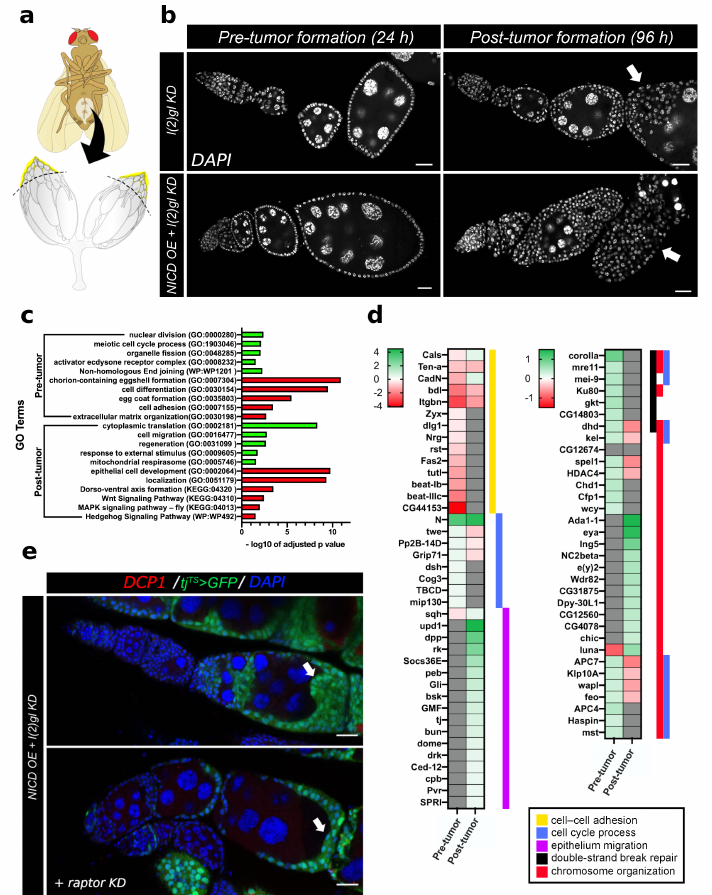
Figure 5. RNA sequencing reveals the Notch-induced genes regulating tumorigenesis and cell survival. ( a ) An illustration of sample collection method. Anterior ovaries, including egg chamber stages up to but not including stage 10A (highlighted in yellow) were collected for library preparation and sequencing. ( b ) Representative confocal images of tumor samples collected at either 24 h (after Gal4 induction but before tumor formation) and 96 h (after significant tumor formation). White (DAPI) marks nuclei. Arrows point to tumor overgrowth in both genetic backgrounds at 96 h. Scale bar = 20 µ m. ( c ) Results from GO term enrichment analysis of pre- and post-tumor genes which were up or down regulated in NICD OE + l(2)gl KD samples compared to l(2)gl KD. Significantly enriched GO terms for upregulated (green) and downregulated (red) genes are shown plotted with respective negative log 10 of adjusted p values. ( d ) Heatmap highlighting expression patterns (LogFC) of select genes from pre- to post-tumor conditions. Colored bars to the right of each heatmap signify the GO term each gene belongs to: cell–cell adhesion (GO:0098609), cell cycle process (GO:0022402), epithelium migration (GO:0090132), double-strand break repair (GO:0006302), or chromosome organization (GO:0051276). ( e ) One gene identified, raptor , is upregulated in NICD OE tumor cells prior to tumor formation (0.57 LogFC) but downregulated following tumor formation ( − 0.51 LogFC). Consistent with a role in Notch-induced tumor formation, raptor knock-down (KD) in an NICD OE + l(2)gl KD background reduces tumor size (arrows). Cell death marked with DCP1 (red), DNA marked with blue), follicle cells expressing GFP (green (DAPI) to mark Gal4 expression. Scale bar = 20 µ